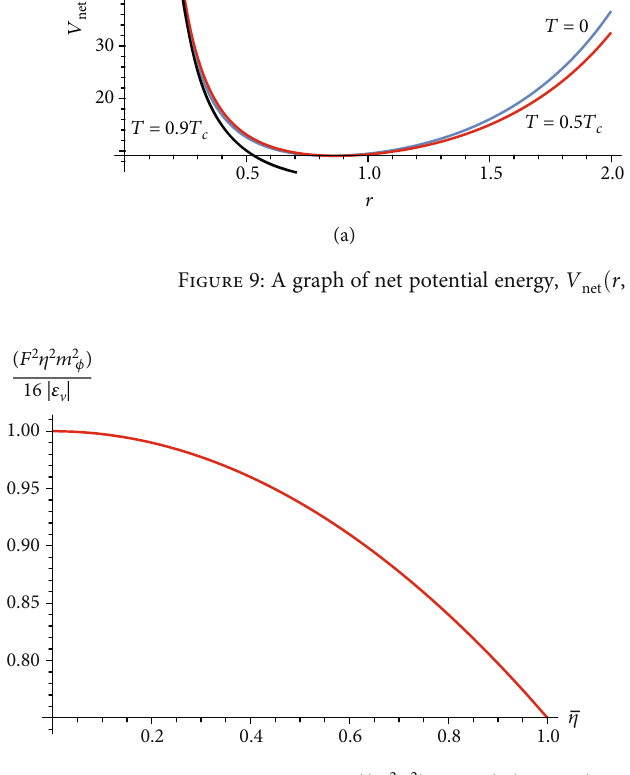
Figure 10: A graph of gluon condensate hð m 2 against (cid:1) η .